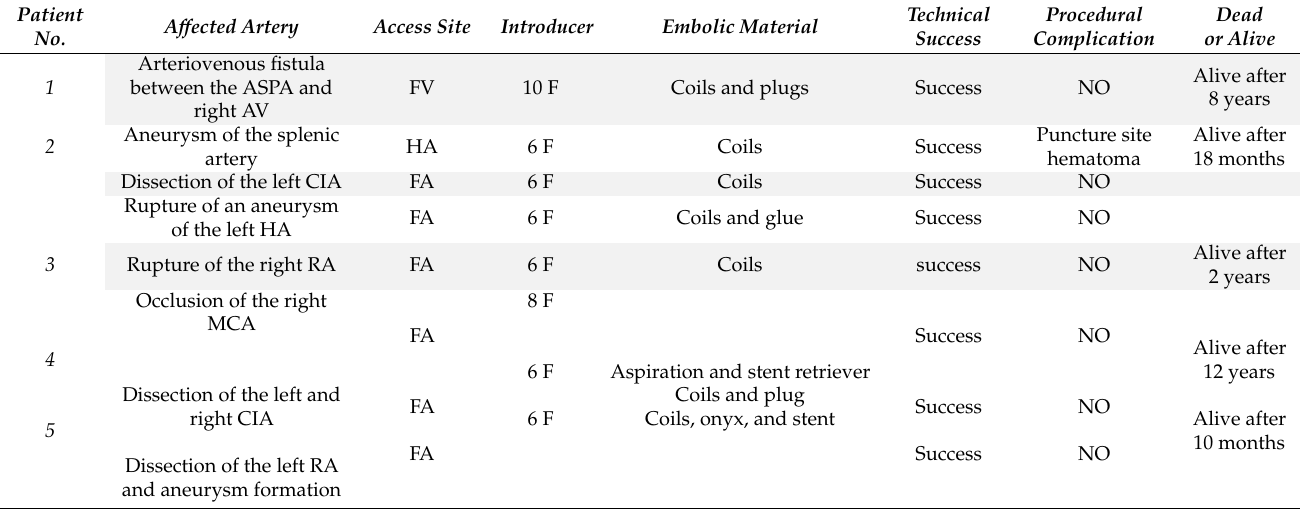
Table A1. Summary of embolization techniques and clinical